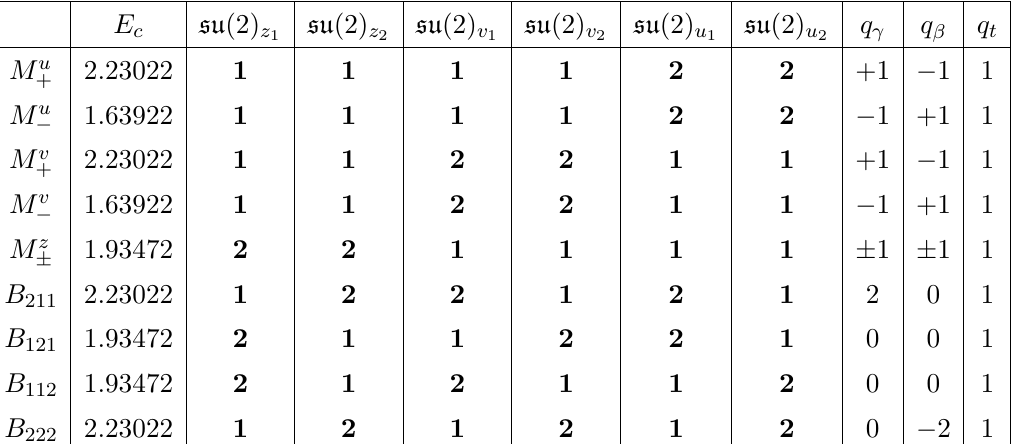
top components of B multiplets and therefore are Higgs branch operators, in r c , (0 , 0)